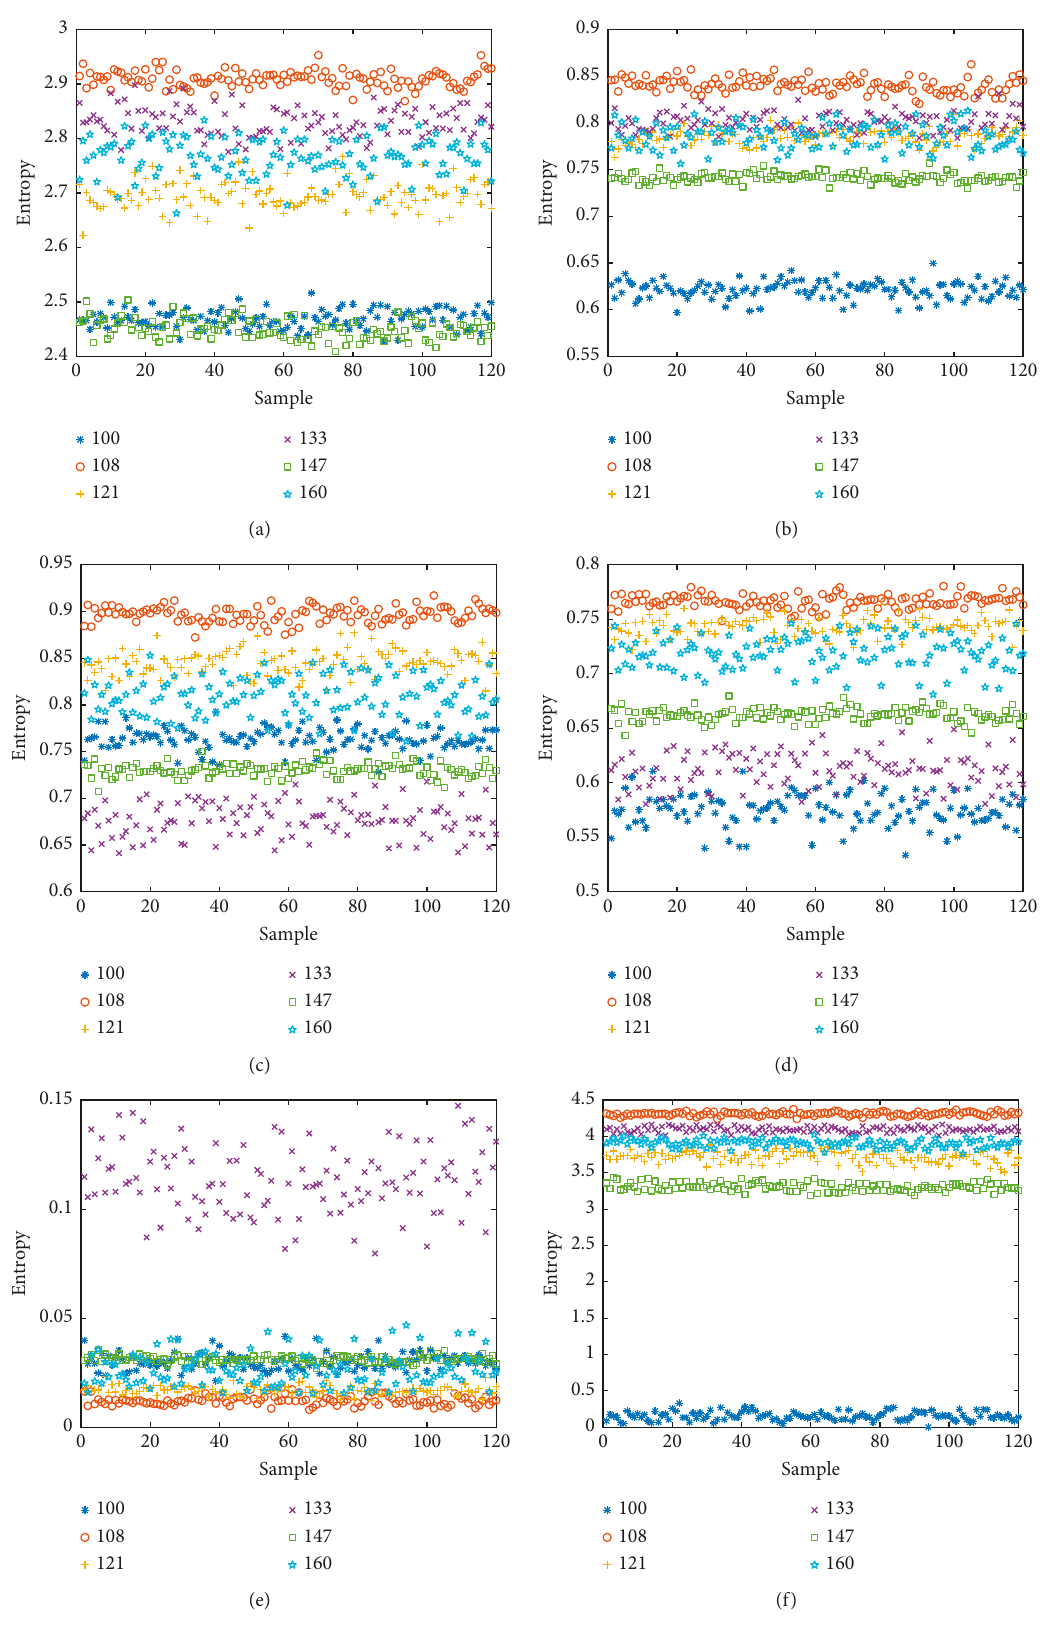
Figure 4: Feature distribution of six types of bearing signals. (a) PE, (b) WPE, (c) DE, (d) FDE, (e) RDE, (f)